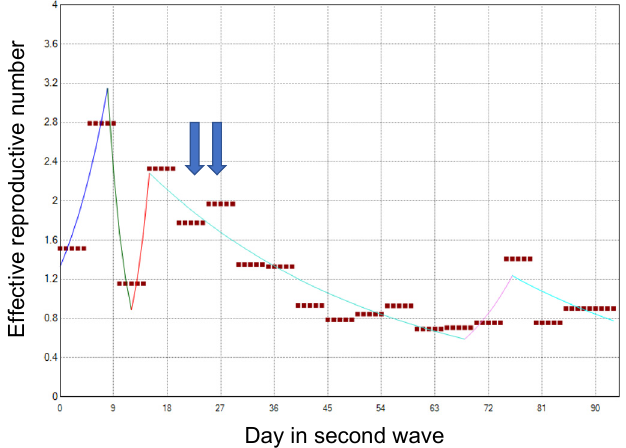
Figure A2. Joinpoint analysis during the second wave of coronavirus disease 2019 in Osaka, Japan. Closed squares indicate the effective reproductive number. The colored line indicates the regression line linking identified joinpoints. Blue arrows represent starting days of two key interventions during the second wave. Day 0 corresponds to 16 June 2020.